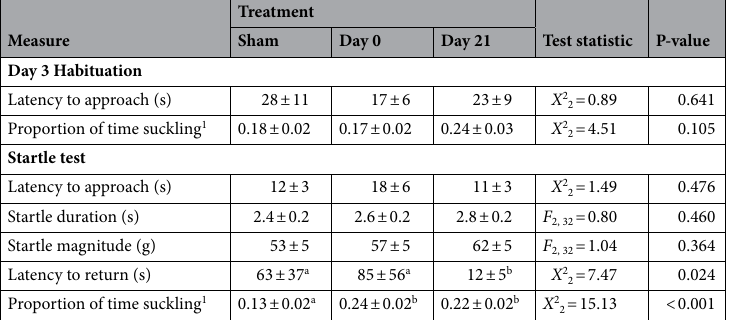
Table 2. Estimated marginal mean ± SE of behaviours in calves disbudded the morning of (Day 0) or 21 days before (Day 21) the startle test, or sham-disbudded (Sham, n = 12/treatment). The startle test consisted of a 10-min period in which a sudden noise was emitted as soon as the calf approached the milk bottle. The day before the startle test, the calf underwent a third and final 15-min period of habituation, in which the milk bottle was present, but no noise was emitted (Day 3 Habituation). Different superscripts indicate treatments differ ( P ≤ 0.080). 1 Estimates are based on the beta regression component of the zero-inflated beta regression model. Thus, zero values are excluded.